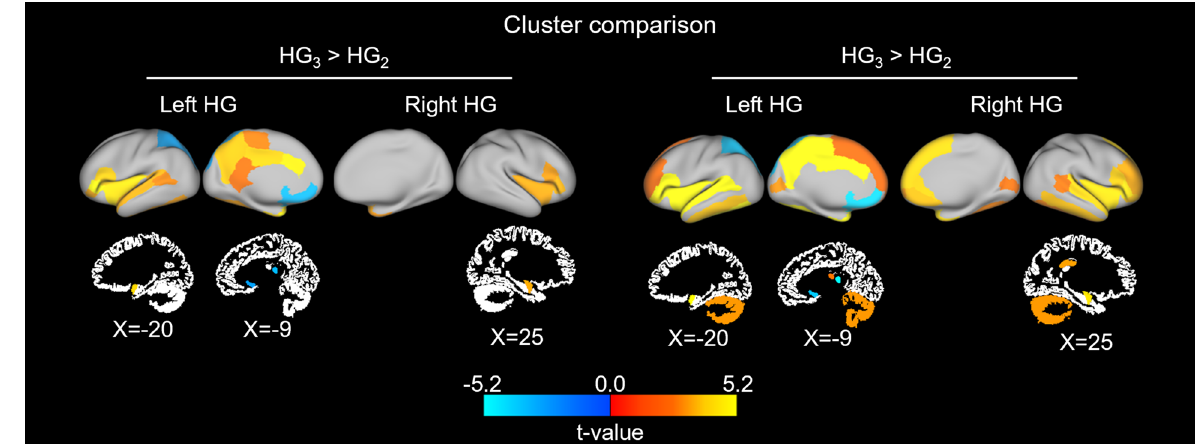
Figure 3. Differences in seed-based functional connectivity between subregion pairs. We visualized t-values that indicated significant differences in functional connectivity between the HG 3 and the HG 1 /HG 2 in the intra- hemispheric cortical and subcortical regions. We did not report the differences between the HG 1 and HG 2 , as there were no significant differences in functional connectivity. ROI,